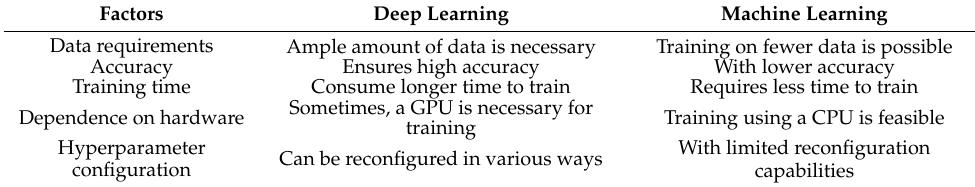
Table 2. Comparison of the factors of machine and deep learning. Factors Deep